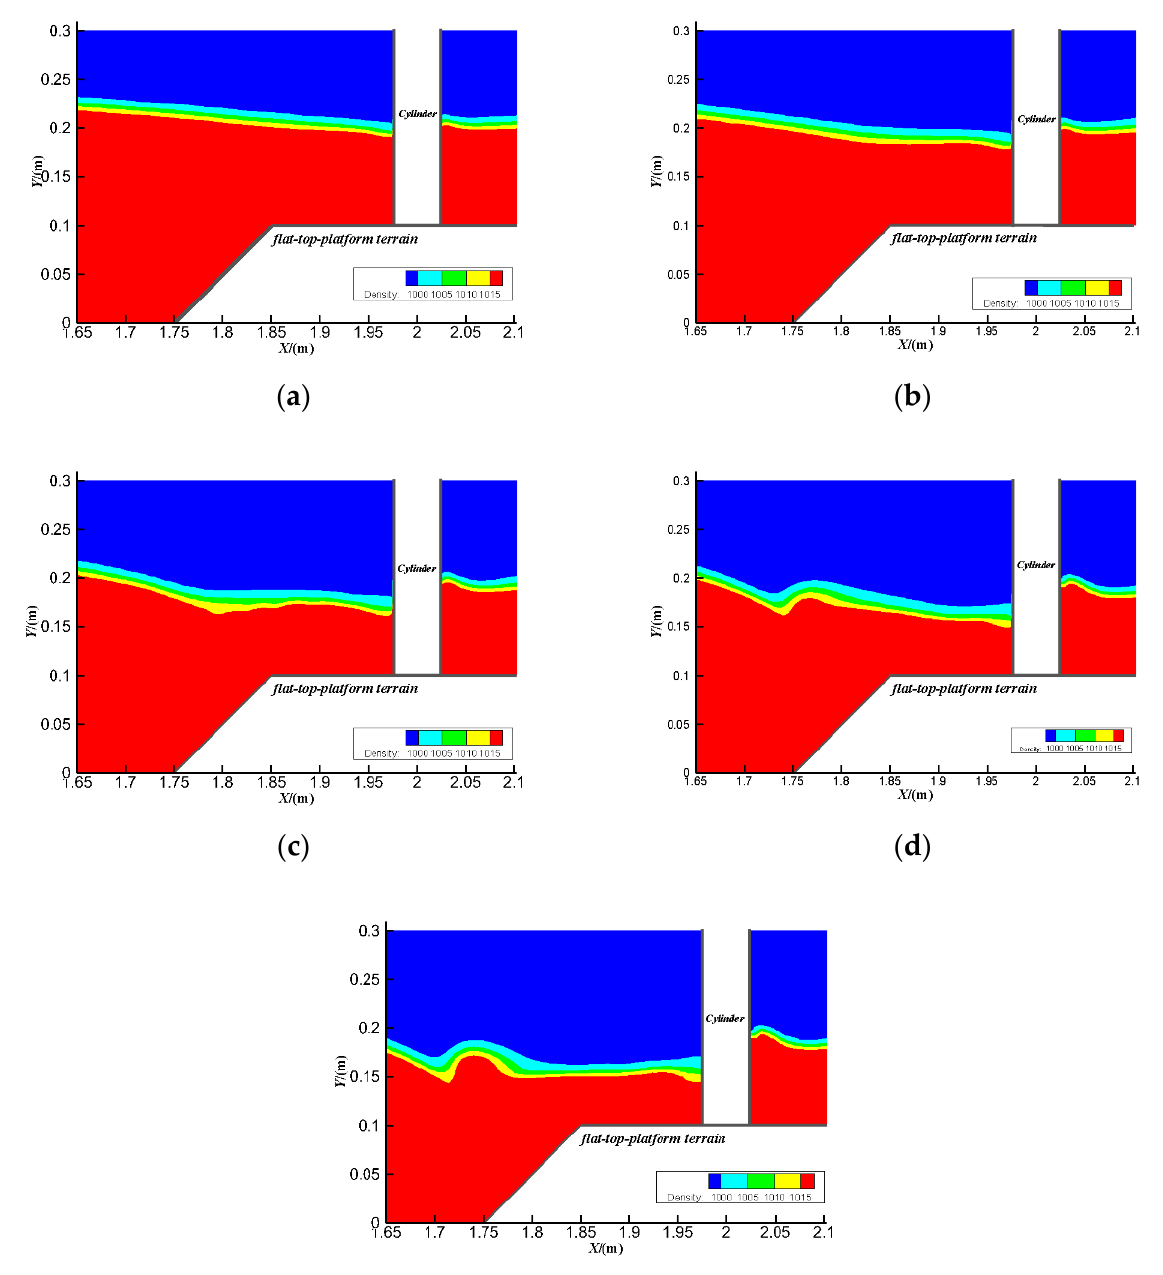
Figure 16. Plots of the density distribution in Z direction, when C Fn = C Fn-max : ( a ) η 0 /H = 0.0275, ( b ) η 0 /H = 0.0384, ( c ) η 0 /H = 0.0494, ( d ) η 0 /H = 0.0575, ( e ) η 0 /H = 0.0674.